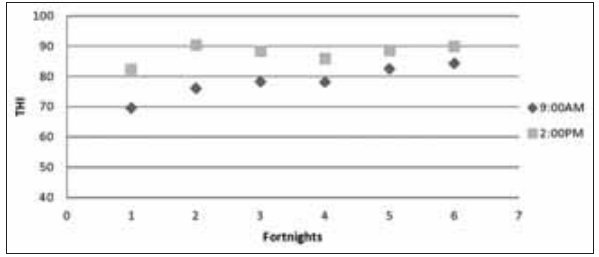
Figure-1: Temperature humidity index of macro climate during